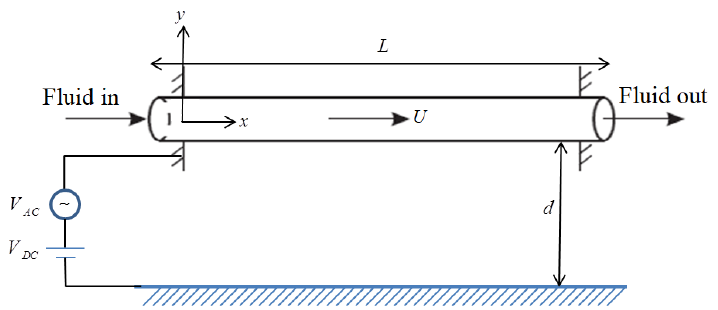
Figure 1. An illustration of a single-walled CNT.